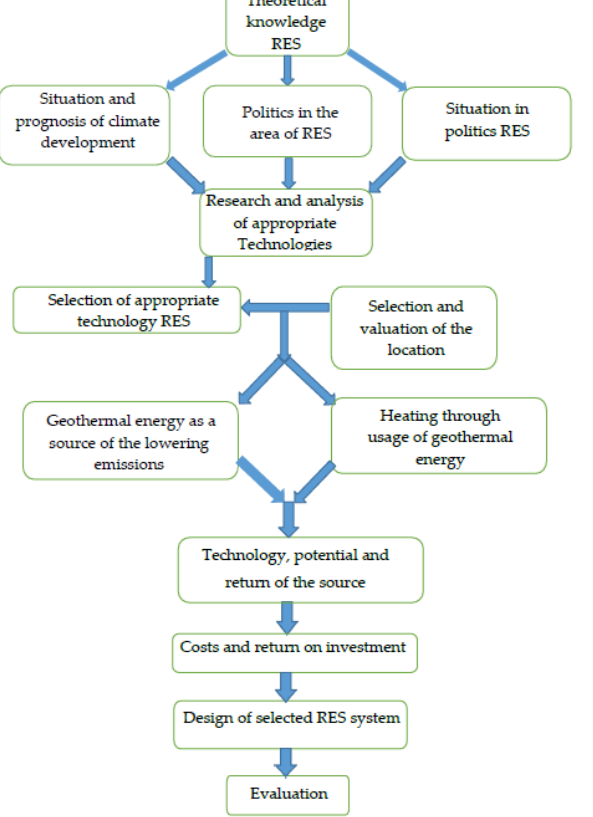
Figure 4 . Flowchart methodology for the work of detecting a suitable GE source. Figure 4. Flowchart methodology for the work of detecting a suitable GE source.